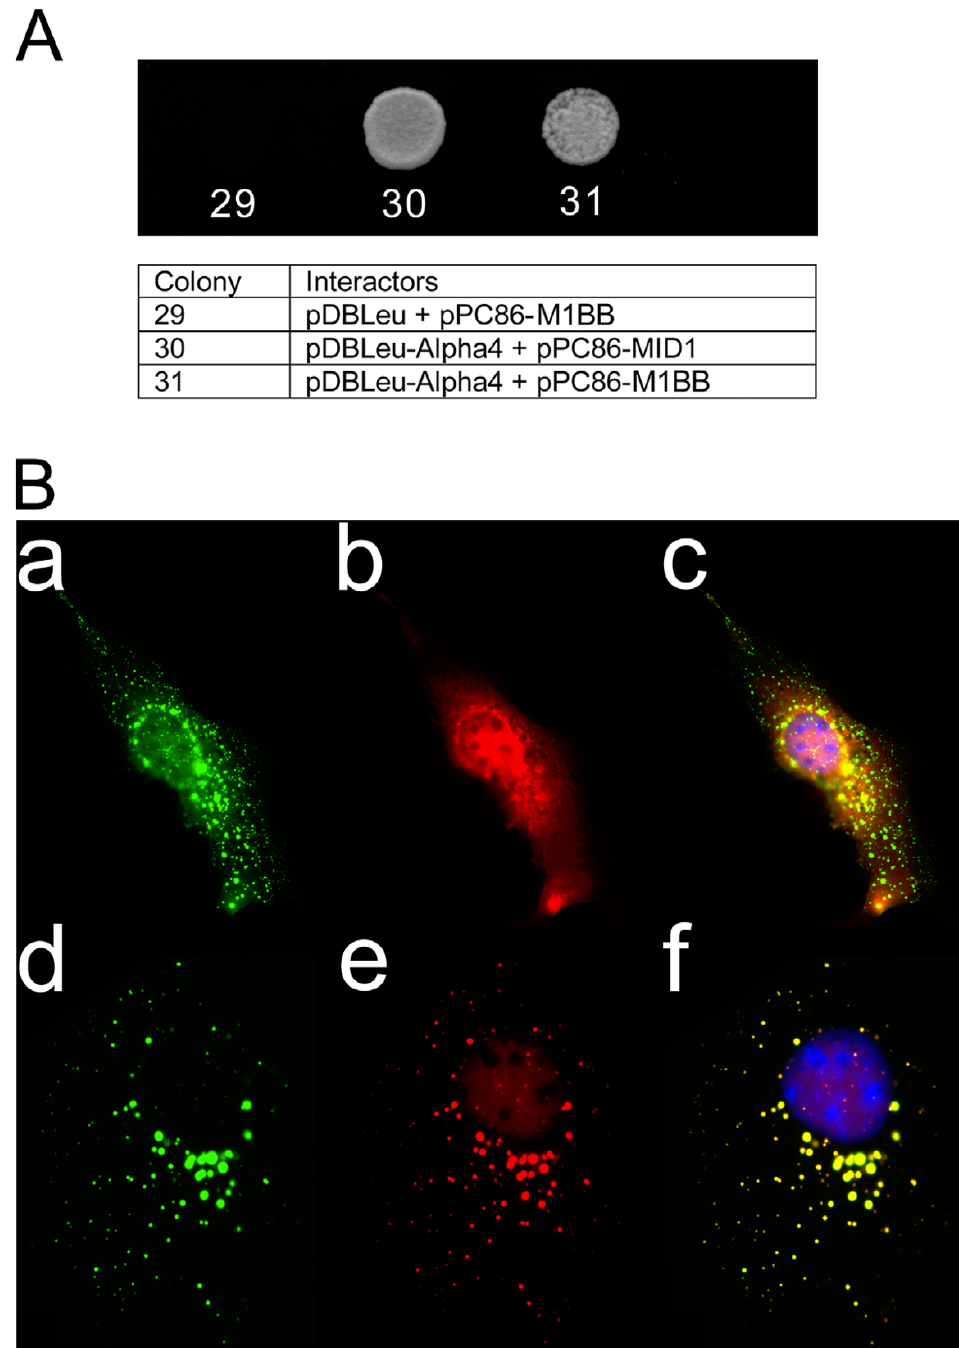
Figure 4 The B-boxes of MID1 are sufficient to bind Alpha 4. (A) Yeast two-hybrid analysis shows that the MID1 B-boxes (pPC86- M1BB) alone can interact with Alpha 4 (pDBLeu-Alpha 4) (31). The wild-type MID1-Alpha 4 interaction (30) and a control with the pPC86-M1BB and no interaction partner (29) were included for comparison. (B) Immunofluorescence assay highlights the importance of the B-boxes for Alpha 4 binding. Subcellular distribution of the GFP-fused MID1 coiled coil domain, GFP-M1CC (a) and myc-Alpha 4 (b) in the same cell shows that the two proteins do not co-localise, as seen in the merged image (c). How- ever, the MID1 fragment, GFP-M1BBCC (d) and the myc-Alpha 4 (e) do co-localise in cytoplasmic speckles as seen in the merged image (f). Both merged images, (c) and (f), also show DAPI stain (blue), which indicates the position of the